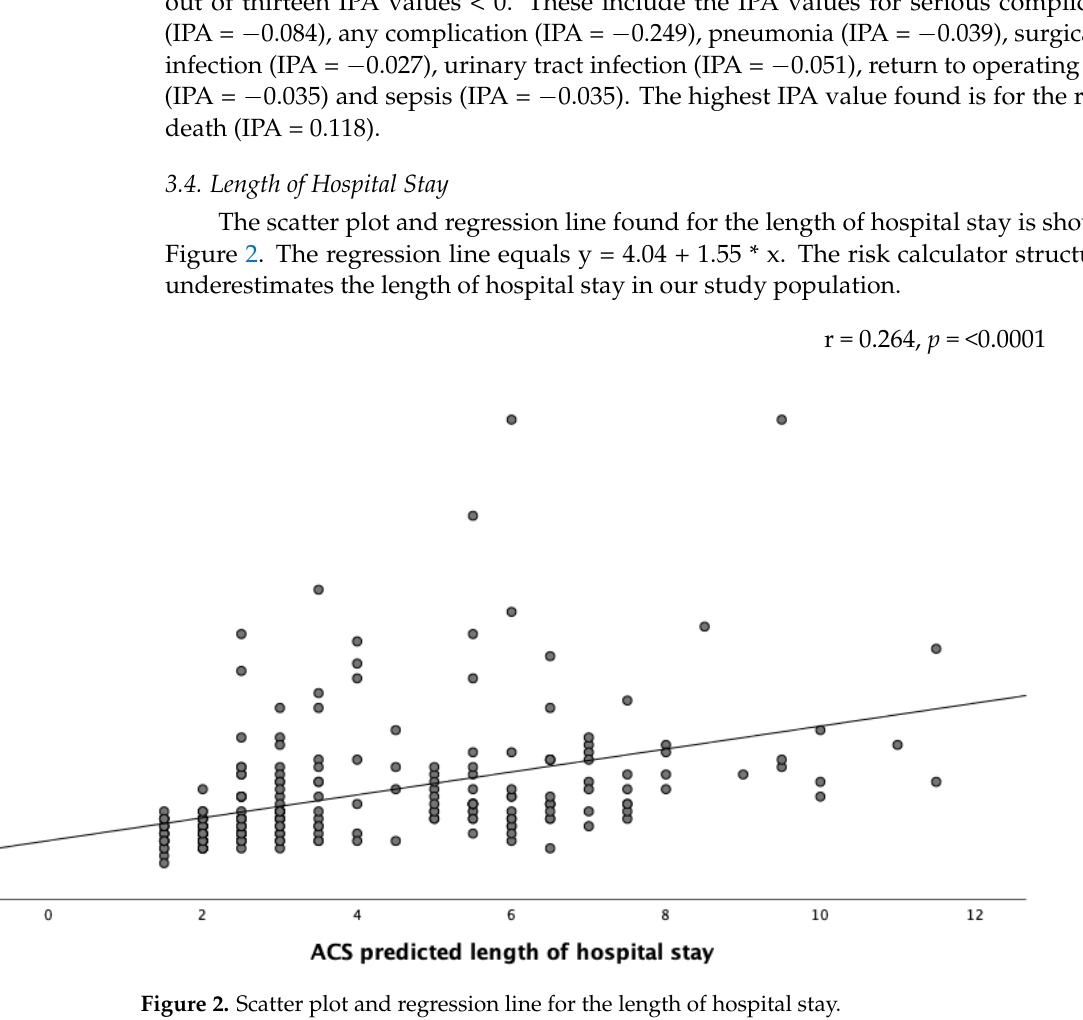
Figure 2. Scatter plot and regression line for the length of hospital stay.